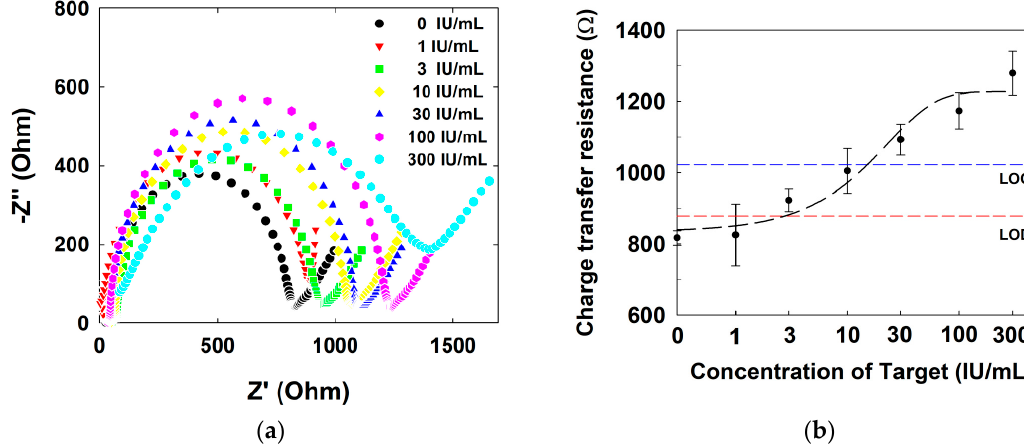
Figure 6. ( a ) Nyquist plot of the electrochemical immunosensor for human IgE at various concentrations of the target IgE from 0 IU / mL to 300 IU / mL. Plots were obtained in a 1 × PBS containing ferri / ferrocyanide (2.5 / 2.5 mM) as a redox probe. ( b ) Calibration curve for the charge transfer resistance depending on the target IgE concentration. The red and blue dashed lines represent the LOD and LOQ, respectively. Each concentration experiment was performed at least five times.